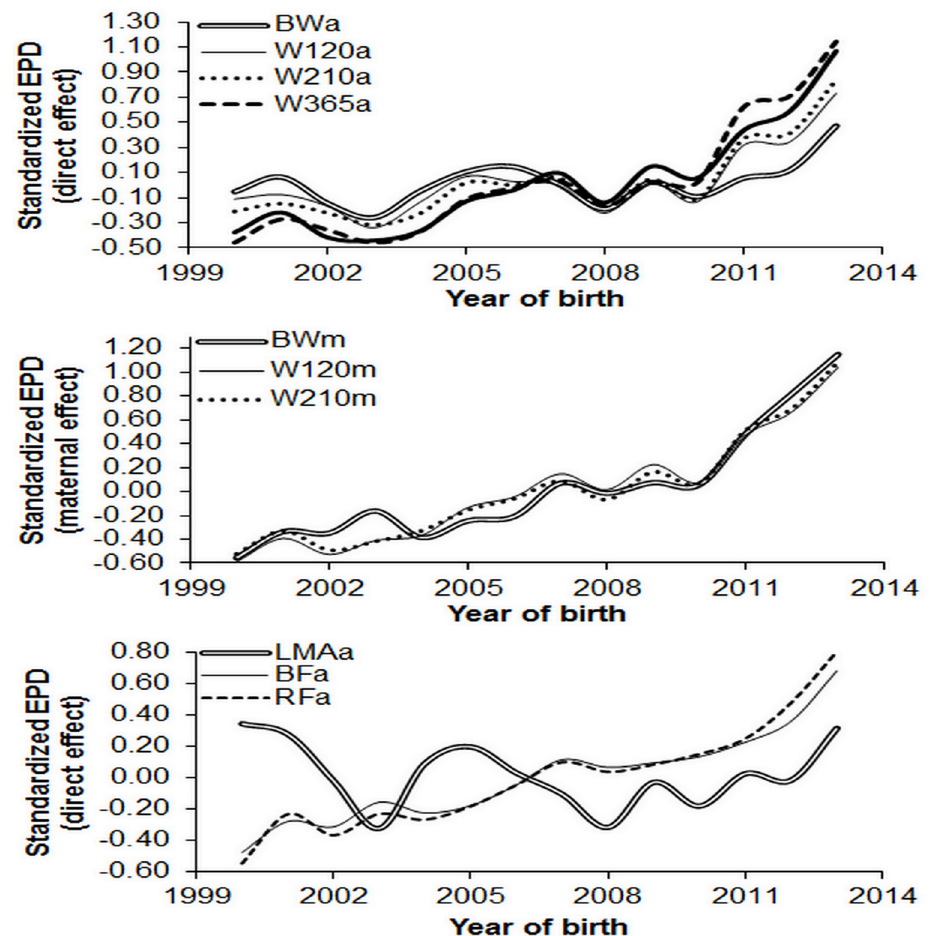
Fig 3. Standardized genetic trends for weights (BW, W120, W210, W365 and W450) and carcass (LMA, BF and RF) traits due to direct and maternal effects. BW, birth weight; W120, weight at 120 days of age; W210, weight at 210 days of age; W365, weight at 365 days of age; W450, weight at 450 days of age; LMA: longissimus muscle area; BF: back-fat thickness; obtained between the 12th and 13th ribs; RF: rump fat